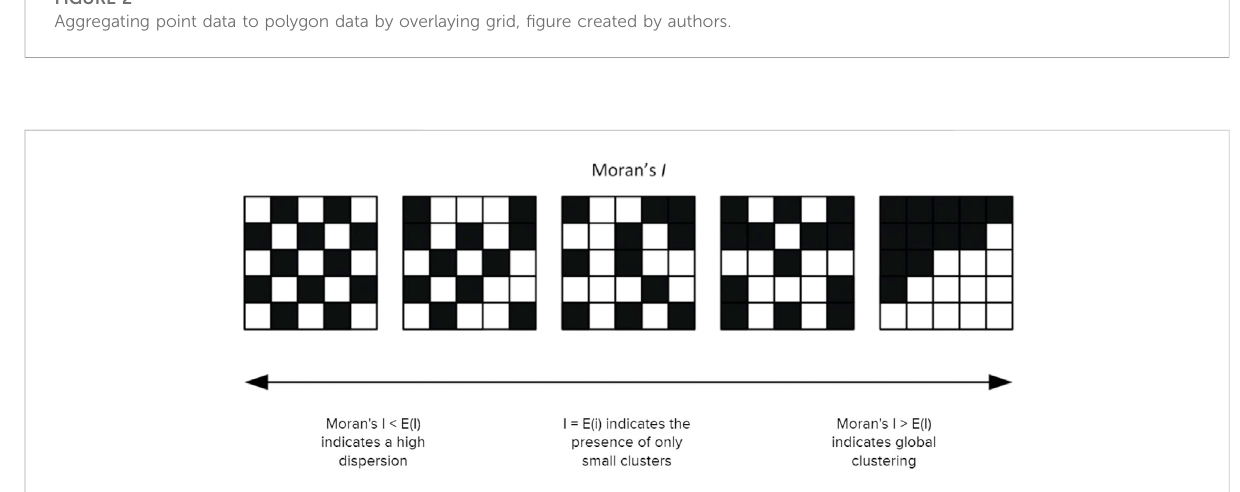
FIGURE 3 Illustration of how map clustering affects Moran ’ s I score. Image adapted from (Kirkegaard 2015).